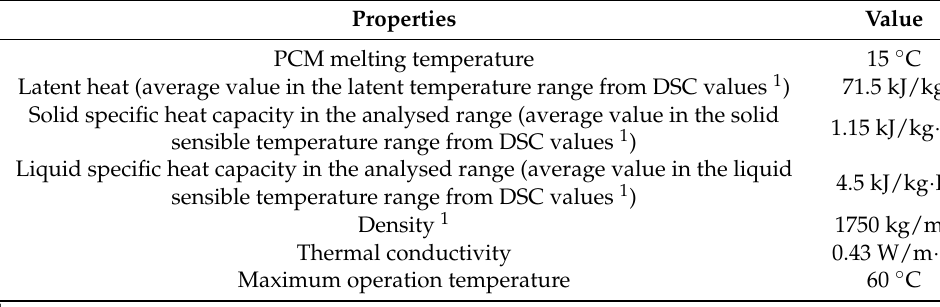
Table 1. Thermophysical properties of PlusICE S15 for the melting process [24]. Properties Latent heat (average value in the latent temperature range from DSC values 1 ) Solid specific heat capacity in the analysed range (average value in the solid sensible temperature range from DSC values 1 ) Liquid specific heat capacity in the analysed range (average value in the liquid sensible temperature range from DSC values 1 )